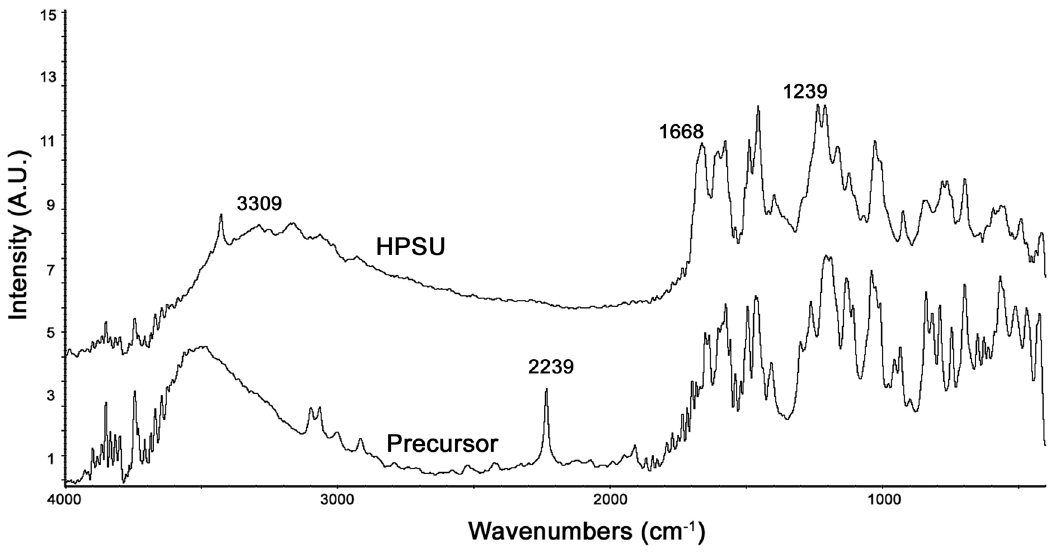
Figure 2. PA-FTIR spectra of the HPSU and its precursor